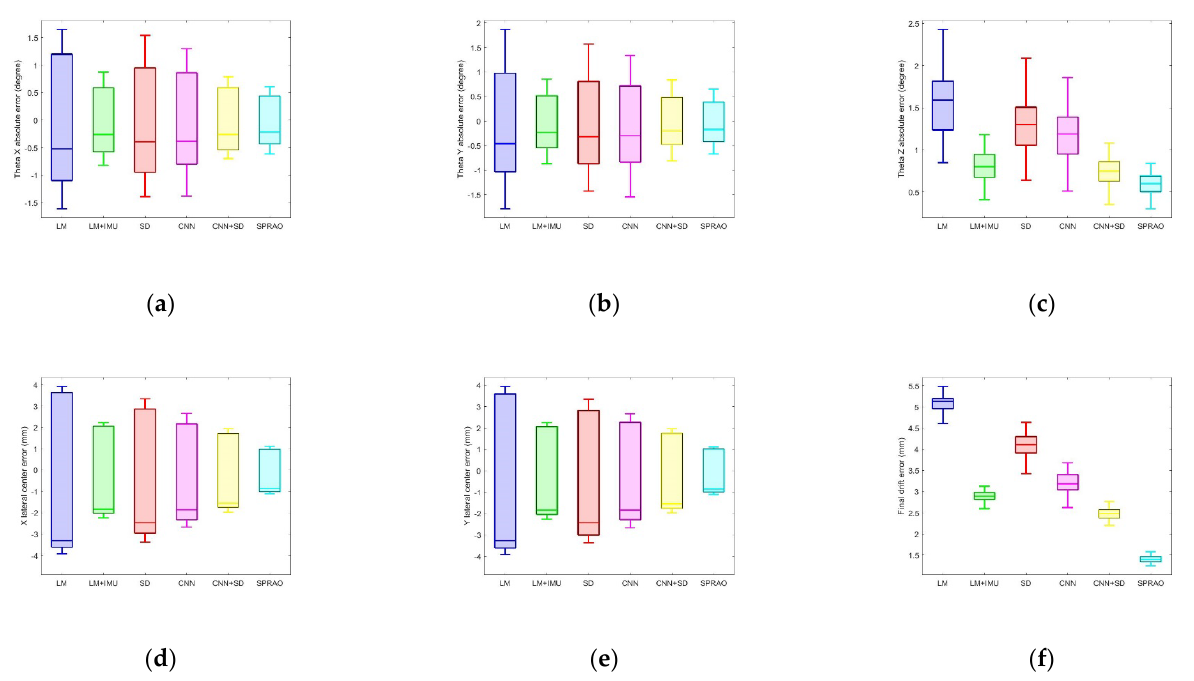
Figure 21. Error of different methods for dataset DB1. ( a ) Theta X; ( b ) Theta Y; ( c ) Theta Z; ( d ) Lateral X; ( e ) Lateral Y; ( f ) Drift.